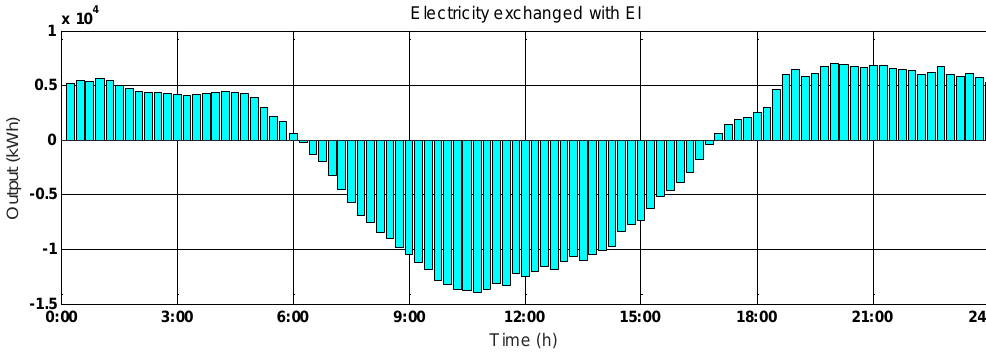
Figure 11. The power exchange between ELAN and the grid in Scenario Four.